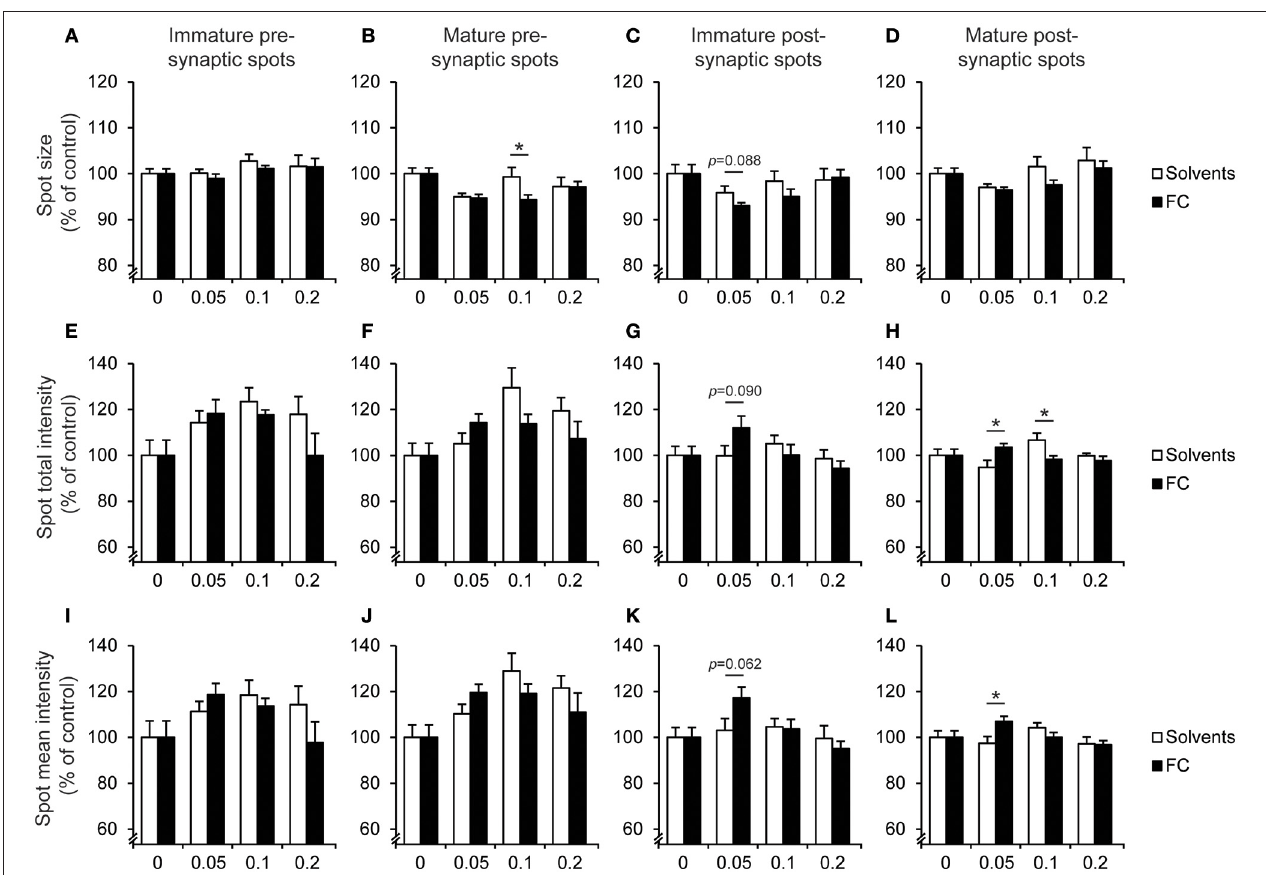
FIGURE 8 | Effect of FC and solvent supplementation on spot morphology of hippocampal neurons co-cultured with astrocytes. Analysis of the effect of supplementation of 0.05x, 0.1x, 0.2x FC or solvents on the morphology of presynaptic immature (A,E,I) and mature (B,F,J) spots as well as postsynaptic immature (C,G,K) and mature (D,H,L) spots. Morphology was determined according to the parameters spot size (A–D) , total intensity of the spot (E–H) and intensity corrected for spot size (I–L) . Data were normalized to non-supplemented condition (0). Error bars represent standard error of the mean (SEM), n = 6–11 wells per condition, * p <